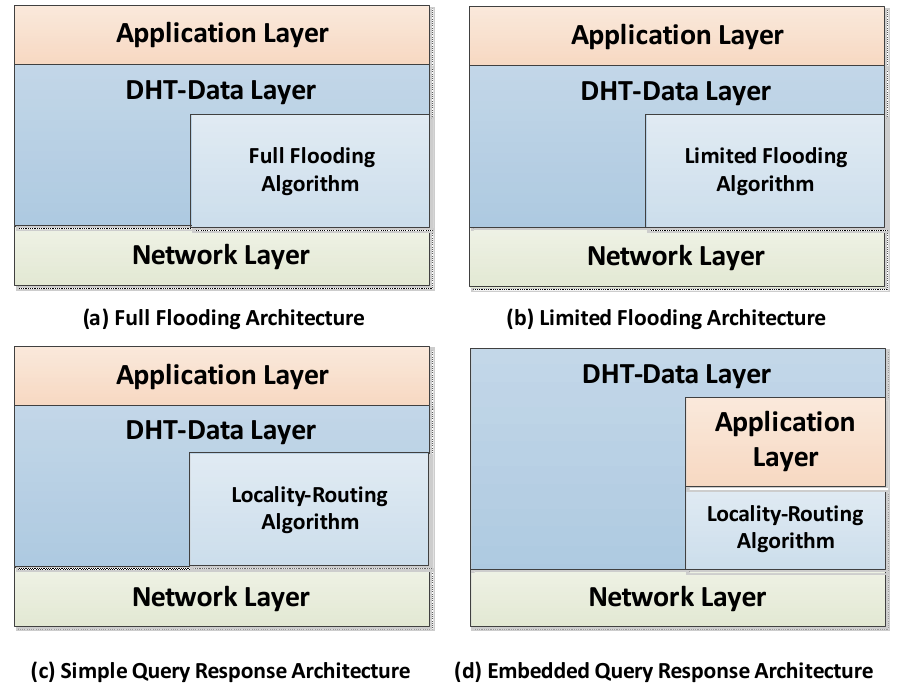
Figure 8. Different approaches with a specific DHT peer algorithm over of the proposed communication architecture.